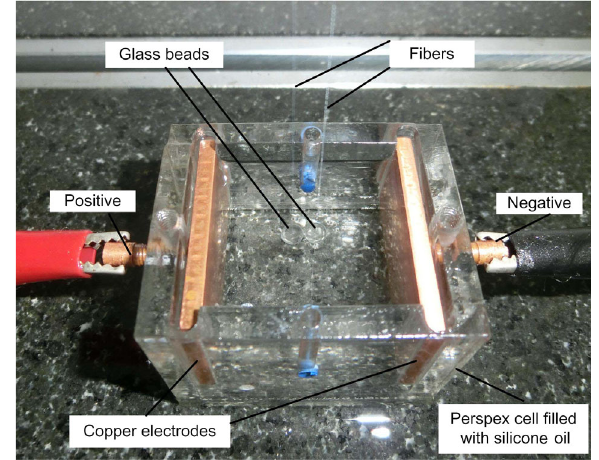
Figure 5 and its insets contain three types of information.